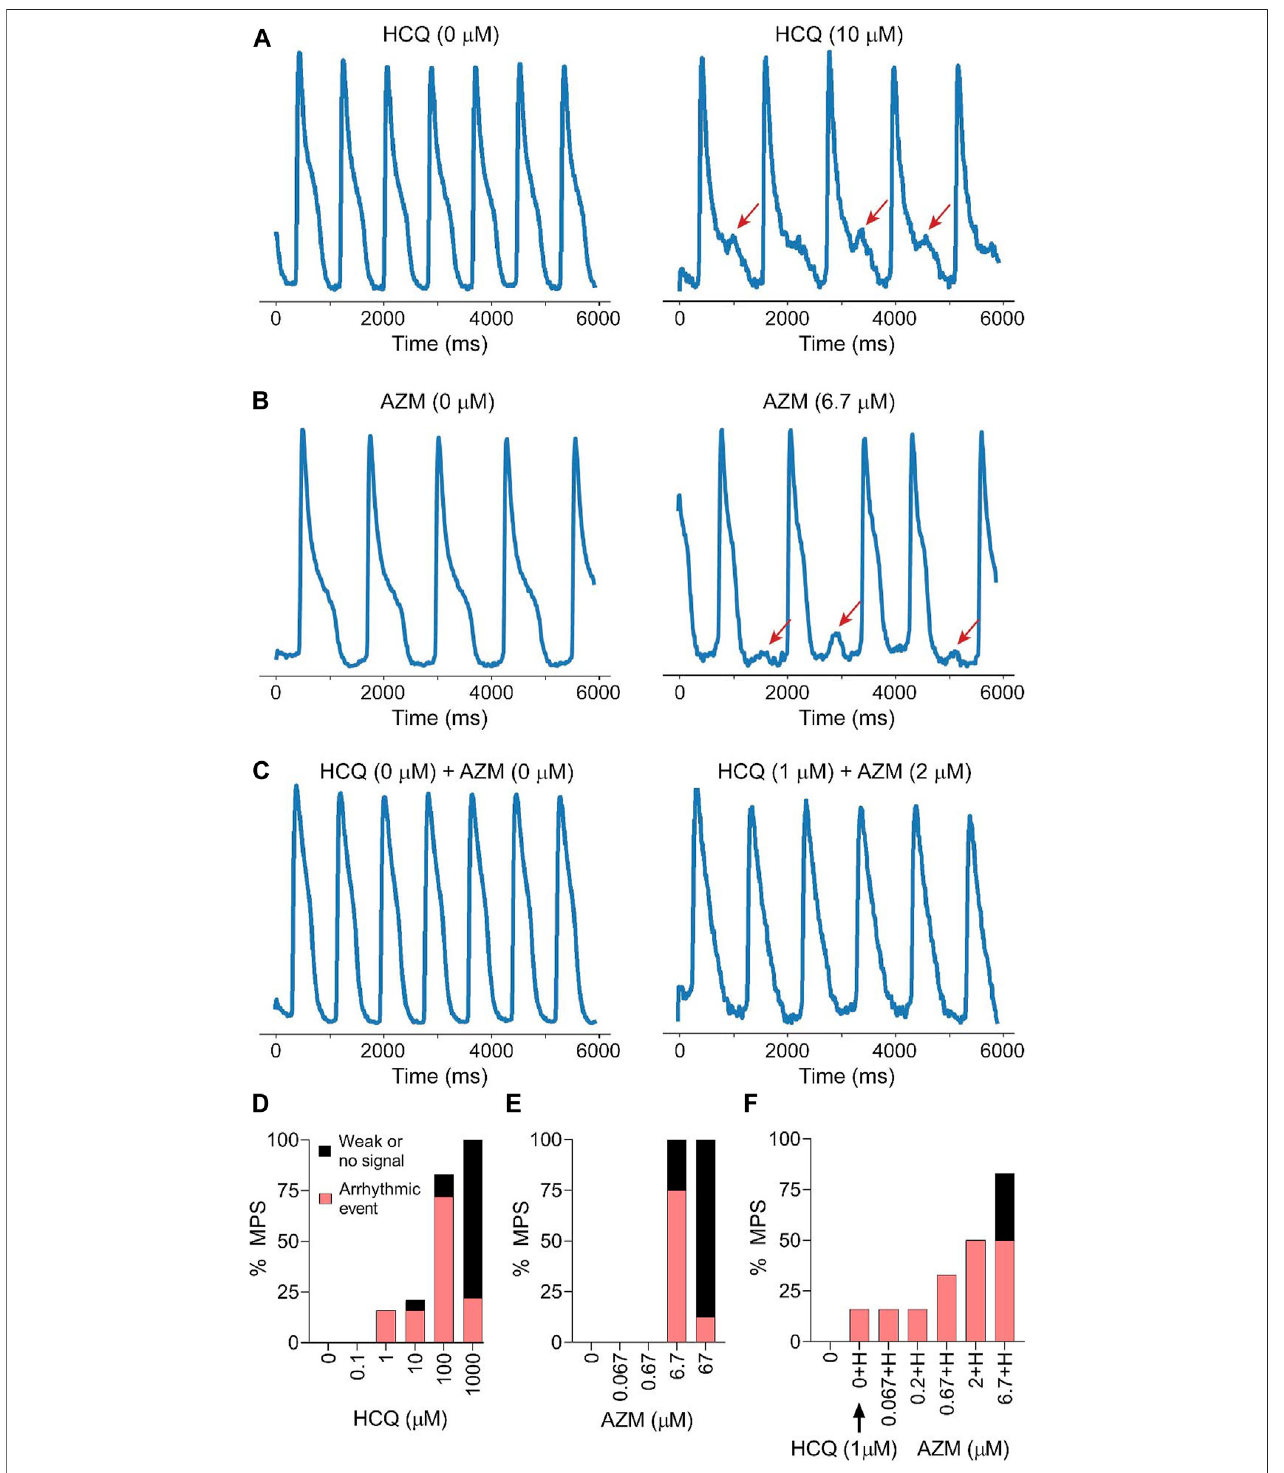
FIGURE 3 | Drug induced arrhythmia for acute HCQ, AZM, and polytherapy. (A) Representative calcium transient trace at baseline (left) and 10 μ M (right) HCQ, whereearlyafter-depolarization(EAD)canbeobserved(redarrows). (B) Representativecalciumtransienttraceatbaseline (left) and6.7 μ M (right) AZM,wheredelayed after-depolarization (DAD) can be observed (red arrows). (C) Representative calcium transient trace at baseline (left) and 1 μ M HCQ combined with 2 μ M AZM (right) , wherecalciumtraceamplitudeandcon fi gurationchange. (D,E,F) Histogramshowingincidenceofarrhythmia-likeeventssuchasEAD,DADorirregularbeatshape (red) and weak signal or beating cecassion (black) as percentage of total MPS for HCQ only (D) , AZM only (E) and combination therapy (F) . Traces used were spontaneous 30 s recording of calcium traces.